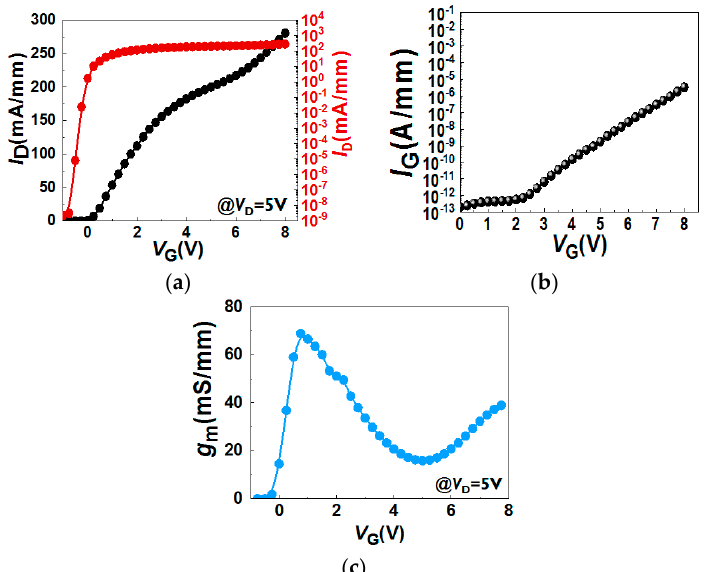
Figure 5. I D – V G ( a ), I G – V G ( b ) and g m – V G ( c ) characteristics in a recessed gate MIS-HEMTs with a 5nm remaining bottom Al 0.2 Ga 0.8 N barrier under the gate. By designing a 5 nm bottom AlGaN barrier with 20% Al content, V TH ~0 V is realized ( V TH is defined at V G of I D = 0.1 mA/mm).